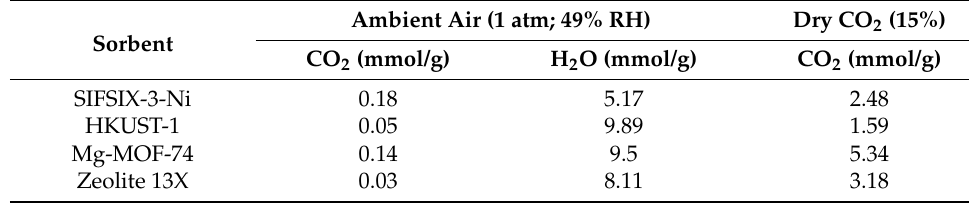
Figure 5 . Typical physisorbent materials. Adapted from [6] . Figure 5. Typical physisorbent materials. Adapted from [6]. Table 1. Adsorption capacity of some physisorbents. Adapted from